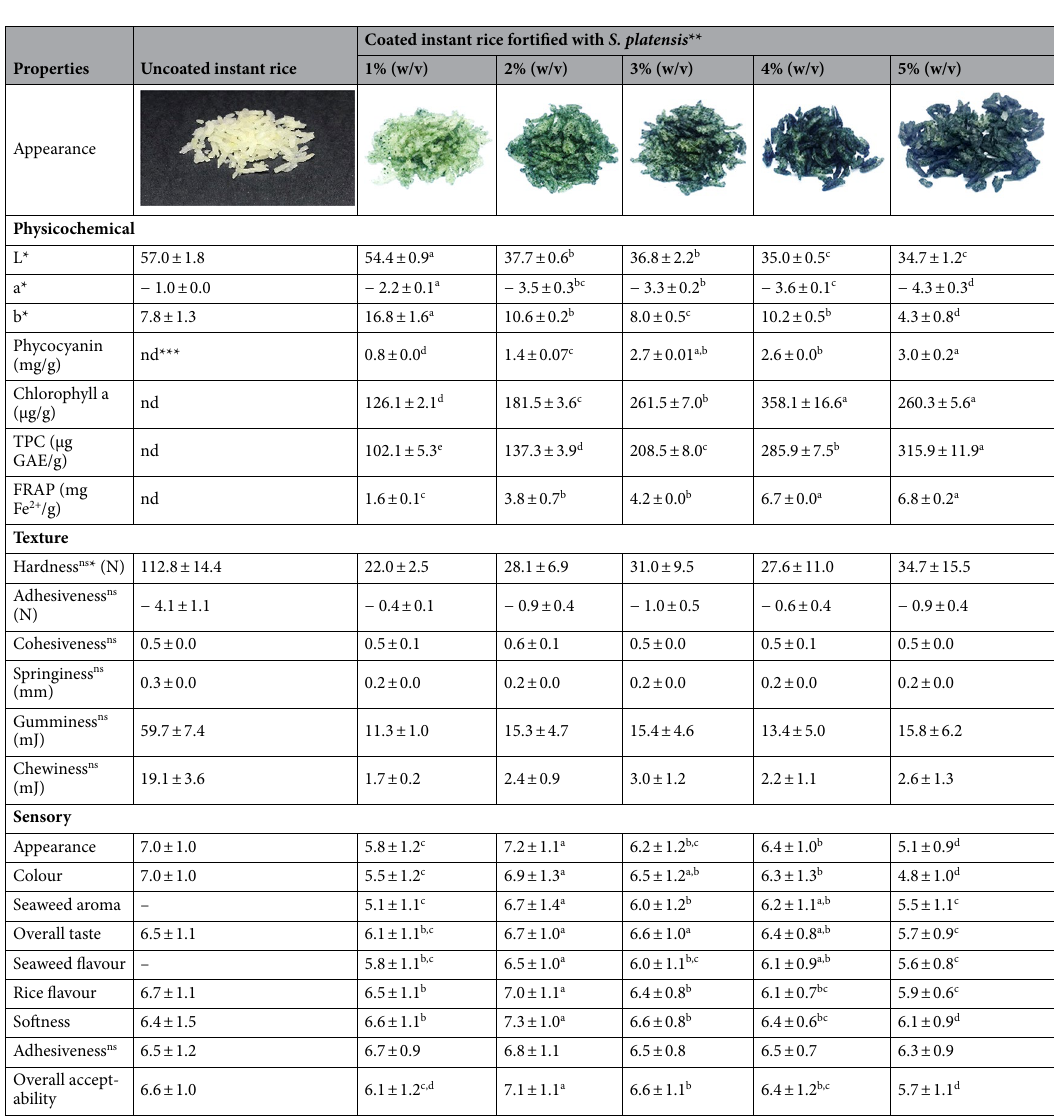
Table 4. Comparative of physicochemical properties, texture properties and sensory acceptance of uncoated and coated instant rice with different concentration of Spirulina. *ns means non-significant at p < 0.05. **a–c represented the significant difference in the rows of coated instant rice at p < 0.05. ***nd means not